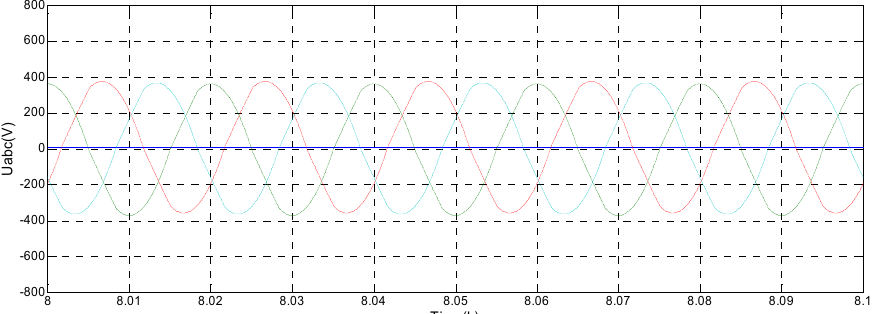
Figure 14. Grid − connected voltage under constant power control.